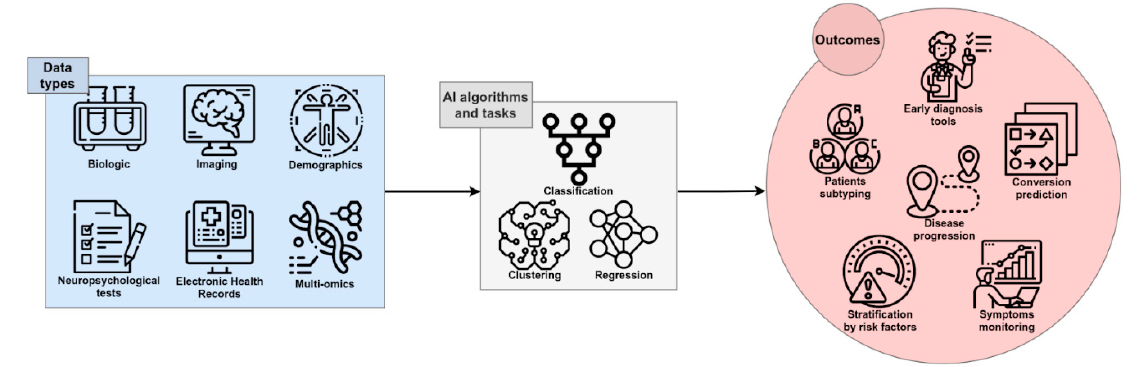
Figure 1. The framework of AI in AD research. Single-modality or integrated data can be processed by several algorithms and tasks, leading to useful outcomes for early and accurate diagnosis, prediction of the course and progression of disease, patient stratification, and discovery of novel therapeutic targets and disease-modifying therapies.